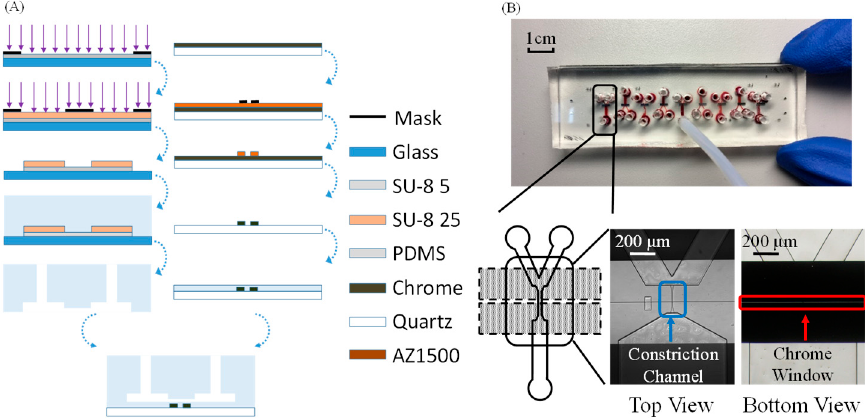
Figure 2. ( A ) Fabrication process and ( B ) a prototype device of the microfluidic module composed of a polydimethylsiloxane (PDMS)-based constriction channel with a patterned chrome window on quartz. The fabrication was based on conventional lithography including key steps of SU-8 exposure, PDMS molding, chrome patterning on quartz, and the bonding of the constriction channel layer and the chrome layer.